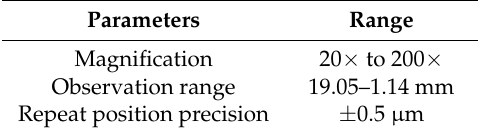
Table 2. Detailed parameters of VHX-600E digital microscope.